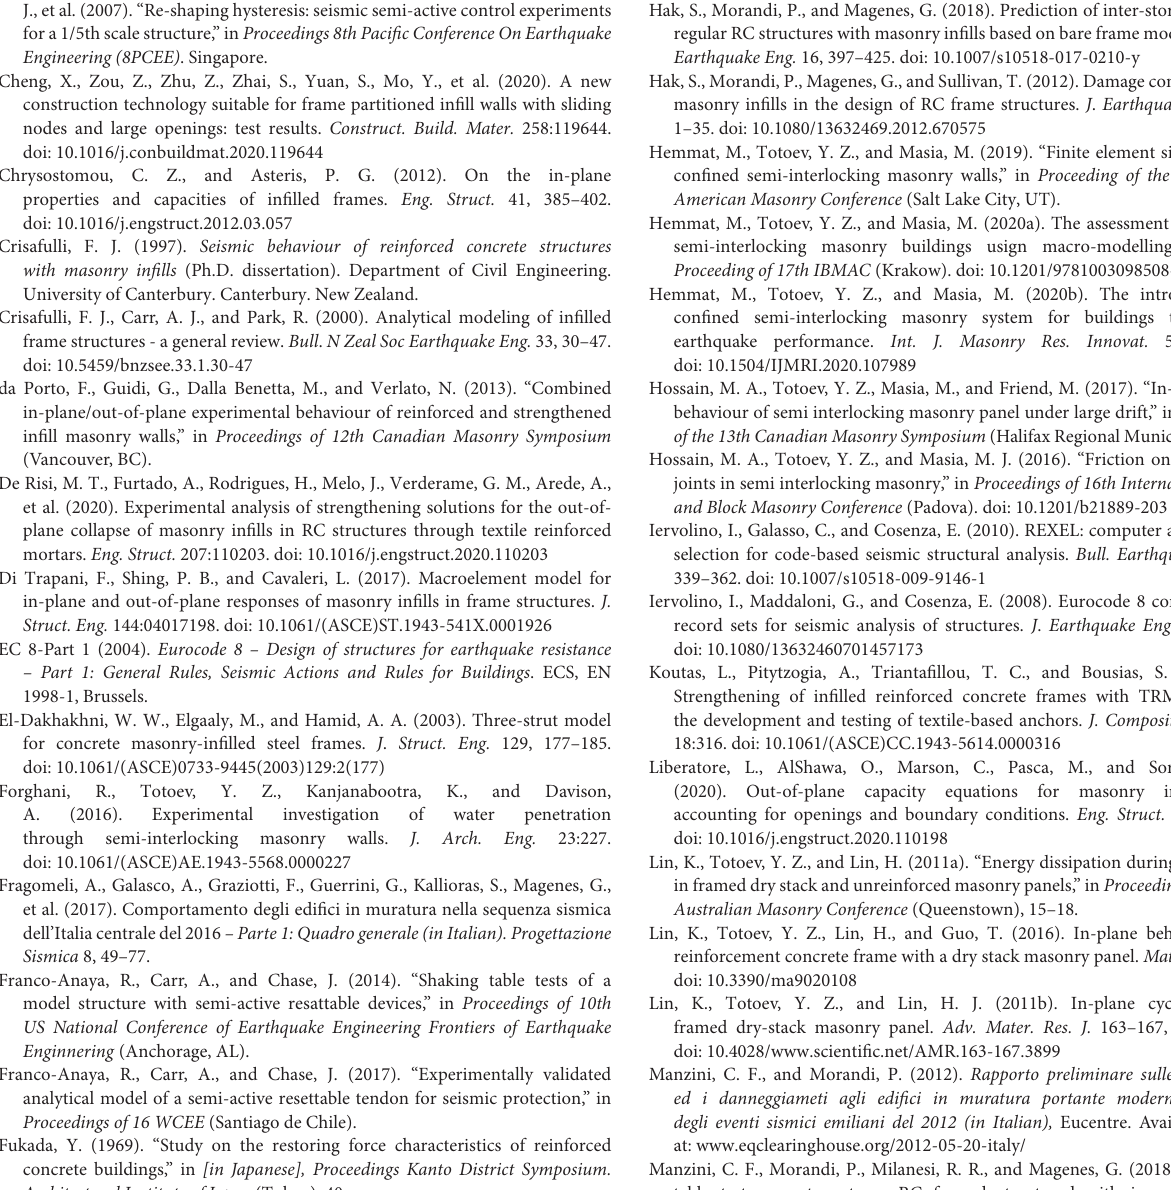
table test on a two-storey RC framed structured with innovative